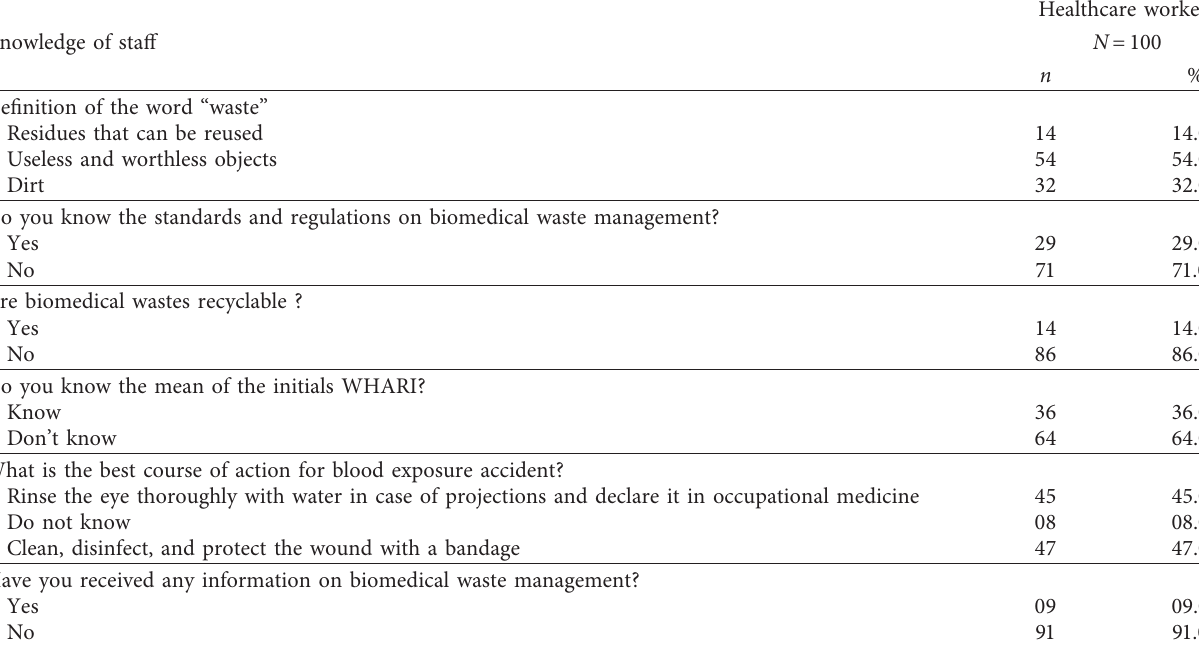
Table 2: Knowledge of healthcare workers on biomedical waste in June 2018.